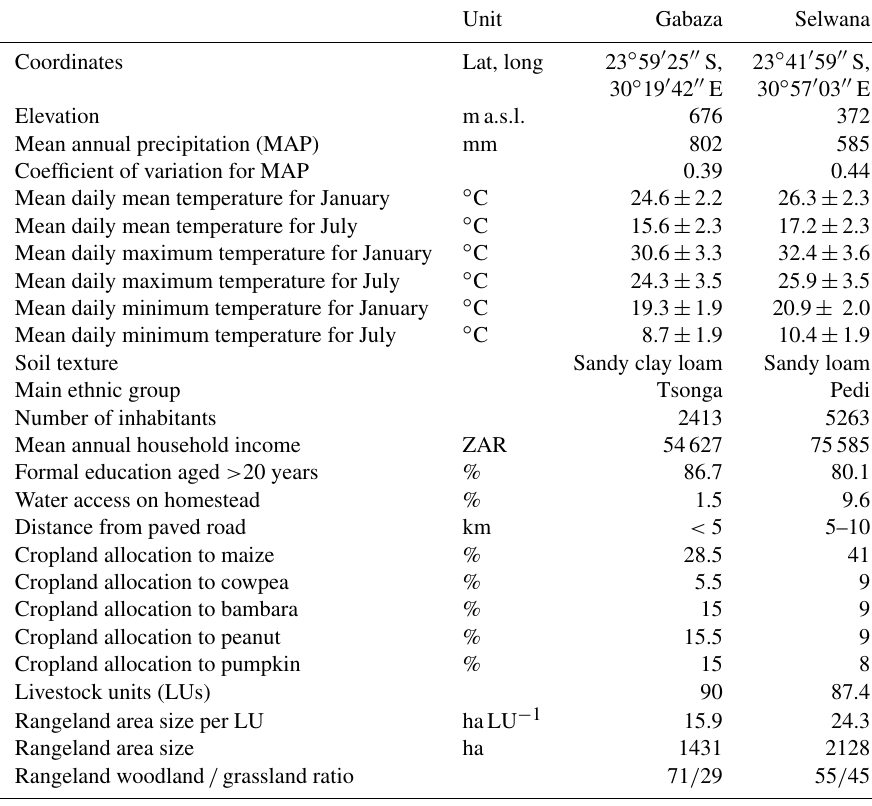
Table 1. Site characteristics of the two selected study villages and cropland usage (% of cropland area) for the most common crop types according to village surveys conducted in